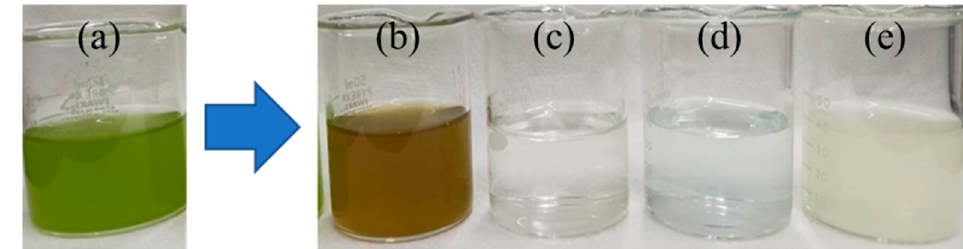
Figure 5. Appearance of suspensions before treatment and after 30 min settling time. ( a ) M. aeruginosa suspension before treatment. Suspensions after settling after treatment using ( b ) Fe anode, ( c ) Al anode, ( d ) Cu anode, and ( e ) Zn anode.